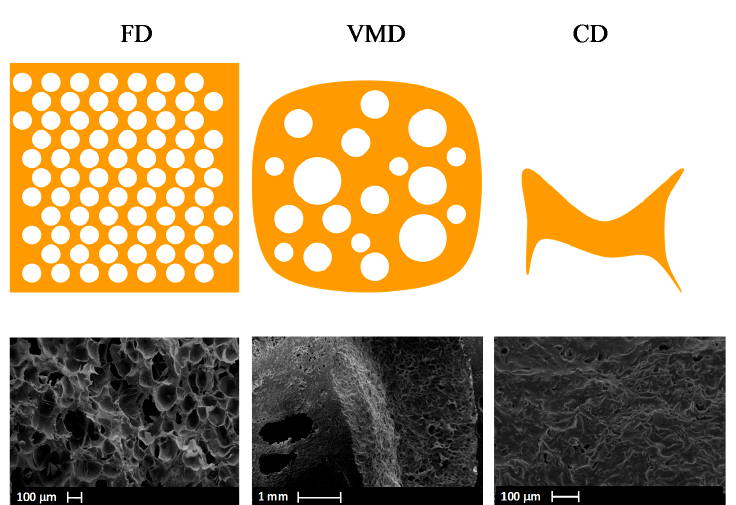
Figure 2. Structure of beetroot samples dehydrated by freeze-drying (FD), vacuum-microwave drying (VMD) and convective drying (CD).